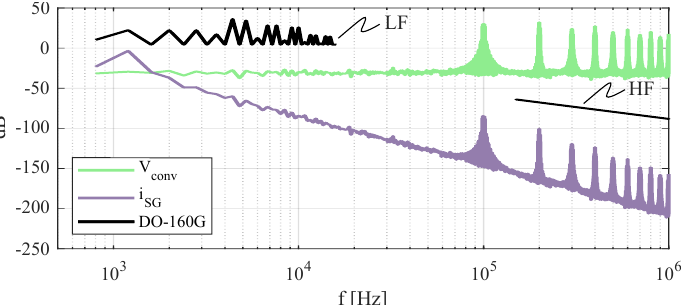
Figure 12. DM input filter results of 2L C architecture for fulfilling LF and HF